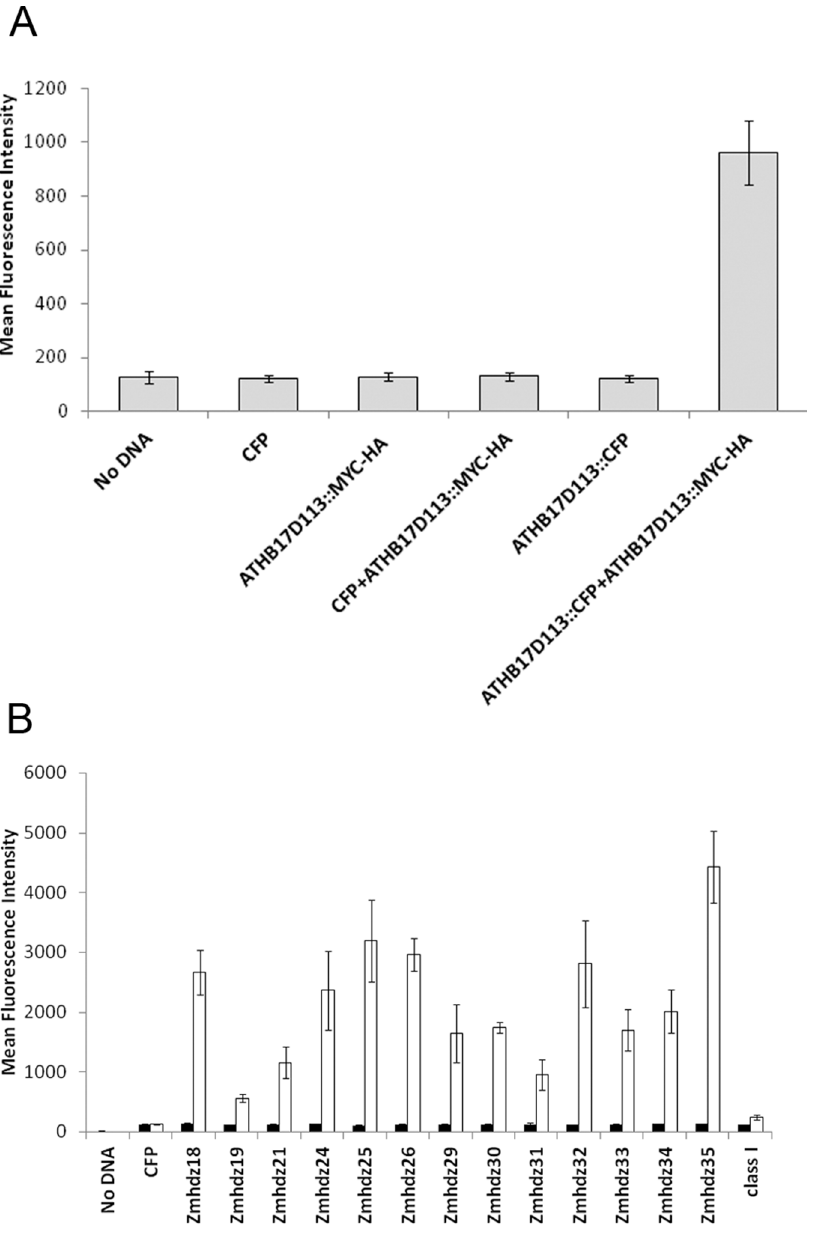
Figure 6. ATHB17 D 113 forms homodimers and makes heterodimers with maize HD-Zip II proteins. Maize leaf protoplasts were (A) mock- transformed or transformed with constructs expressing CFP, MYC::HA and CFP tagged ATHB17 D 113 alone or CFP and ATHB17 D 113::CFP in combination with ATHB17 D 113::MYC construct, (B) transformed (filled bars) with constructs expressing CFP or each of the CFP tagged HD-Zip IIs alone or co-transformed (empty bars) with the construct expressing ATHB17 D 113::MYC-HA. Cellular extracts were co-immunoprecipitated using anti- MYC antibody and the immunoprecipitated complex was probed with anti-CFP antibody and visualized using phycoerythrin-conjugated reporter molecules. One HD-Zip I, Zmhdz3, was used to evaluate interaction with ATHB17 D 113. Nomenclature of HD-Zip II and HD-Zip I constructs is based on Zhao et al.[22].